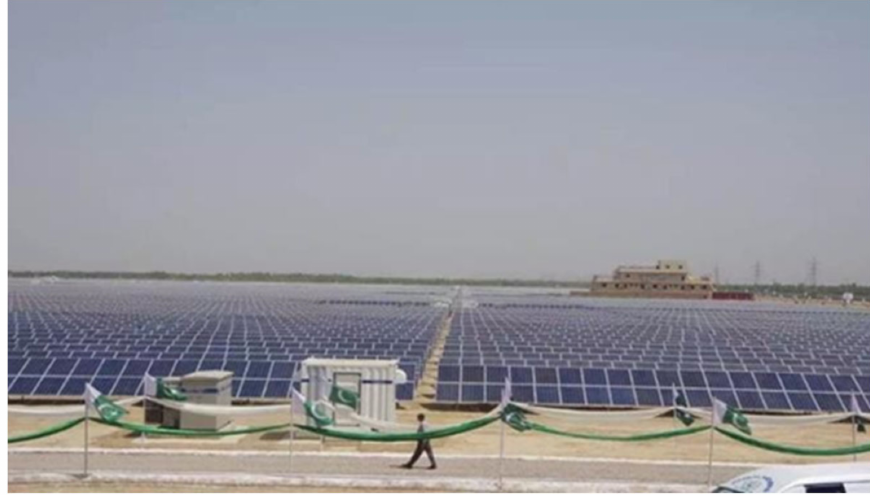
Figure 1. Arena view of 100 MW Quaid-e-Azam Solar Park